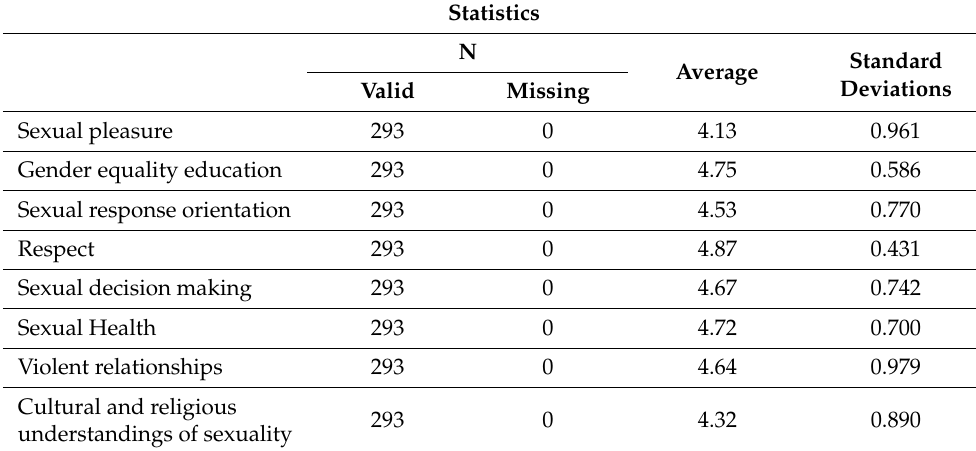
Table 3. Degree of the importance of the topics to be dealt with in sexual education at university.